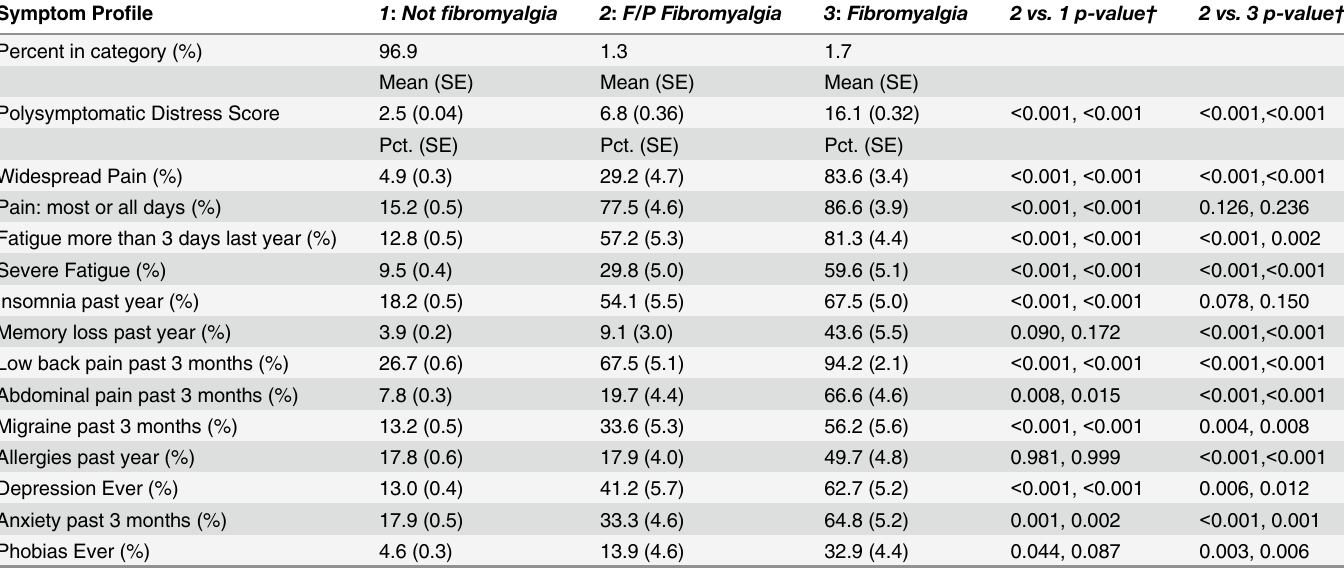
Table 2. Comparison of somatic and psychological symptoms between persons without fibromyalgia, FP fibromyalgia, and those that meet NHIS fibromyalgia criteria. Symptom Pro fi le 1 : Not fi bromyalgia 2 : F/P